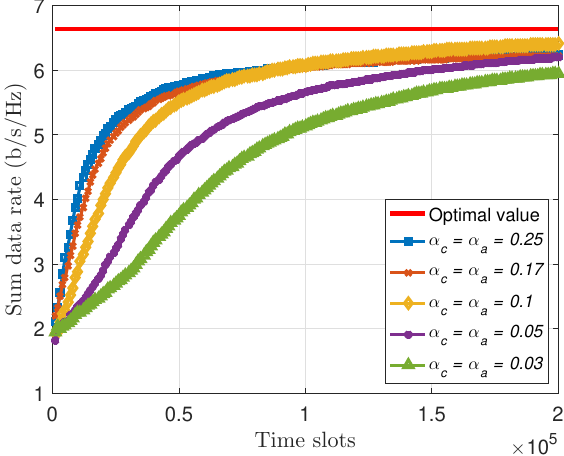
Figure 6. The convergence of the proposed actor-critic-based algorithm according to the mean value of harvested